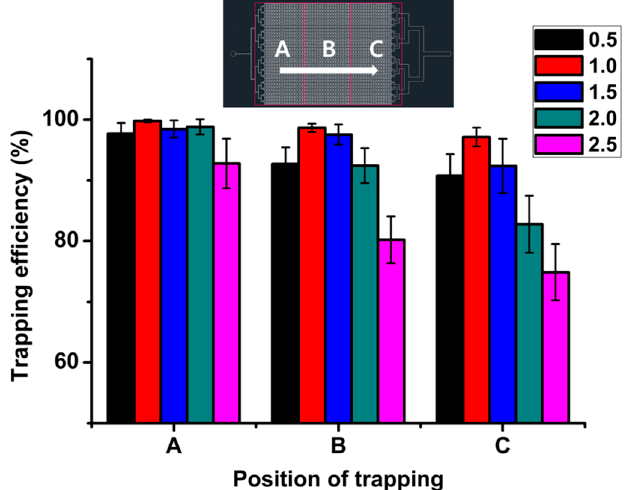
Figure 6. Trapping efficiency of sample in parallel microfluidic device according to various positions.